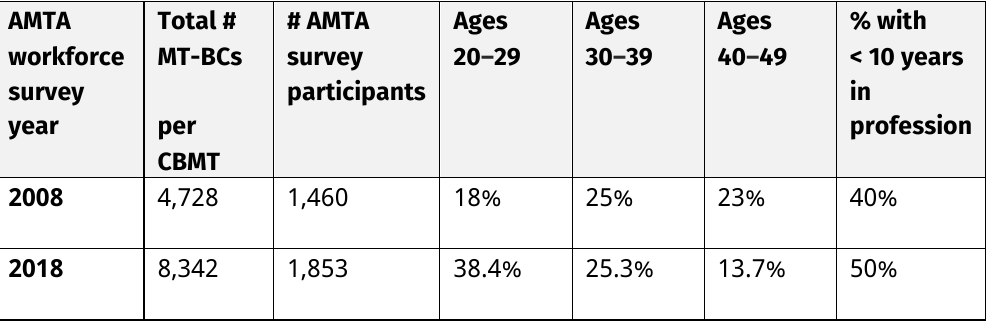
Table 1. AMTA Workforce Survey Responses for Age and Professional Longevity. (AMTA, 2009 & 2019)